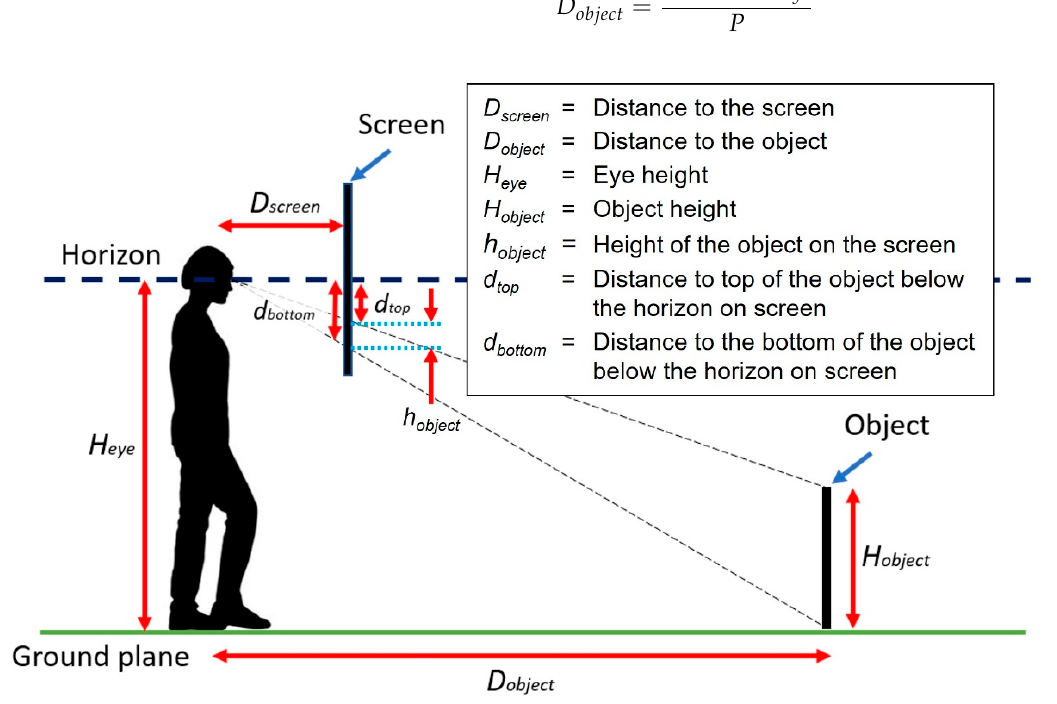
Figure 2. Geometry of an object represented on a 2D platform (the screen). The elevation of the object on the screen can be calculated with: d bottom = D screen the screen can be expressed as h object or: h object = d bottom − d top = H object × D screen